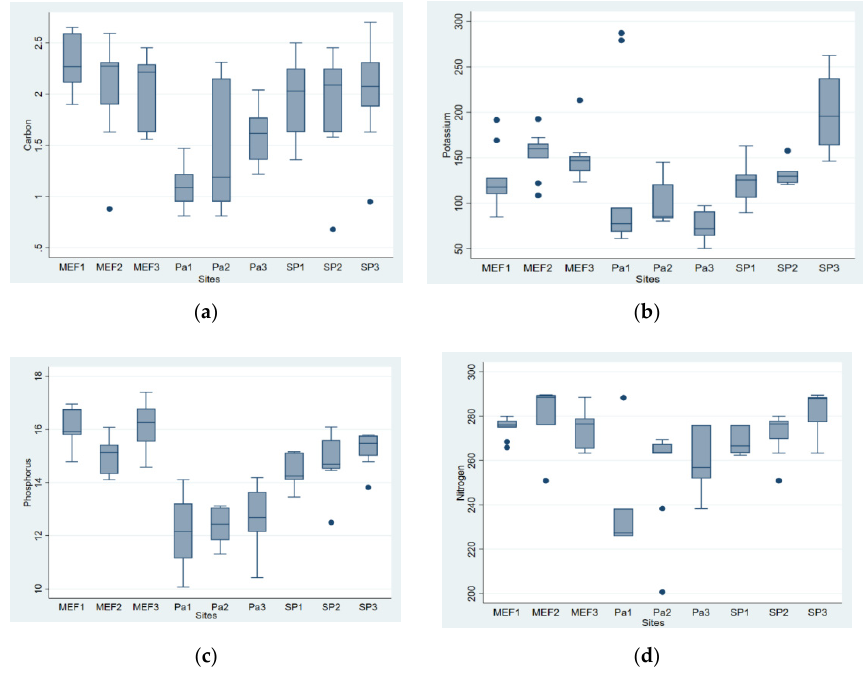
Figure 5. ( a ) Land use − wise carbon concentration (%), ( b ) land use-wise available potassium concentration (kg/ha), ( c ) land use-wise available phosphorus concentration (kg/ha), ( d ) land use-wise available nitrogen concentration (kg/ha); the blue dotes (outliers) in all figures are used show some anomalous results were observed in replications.